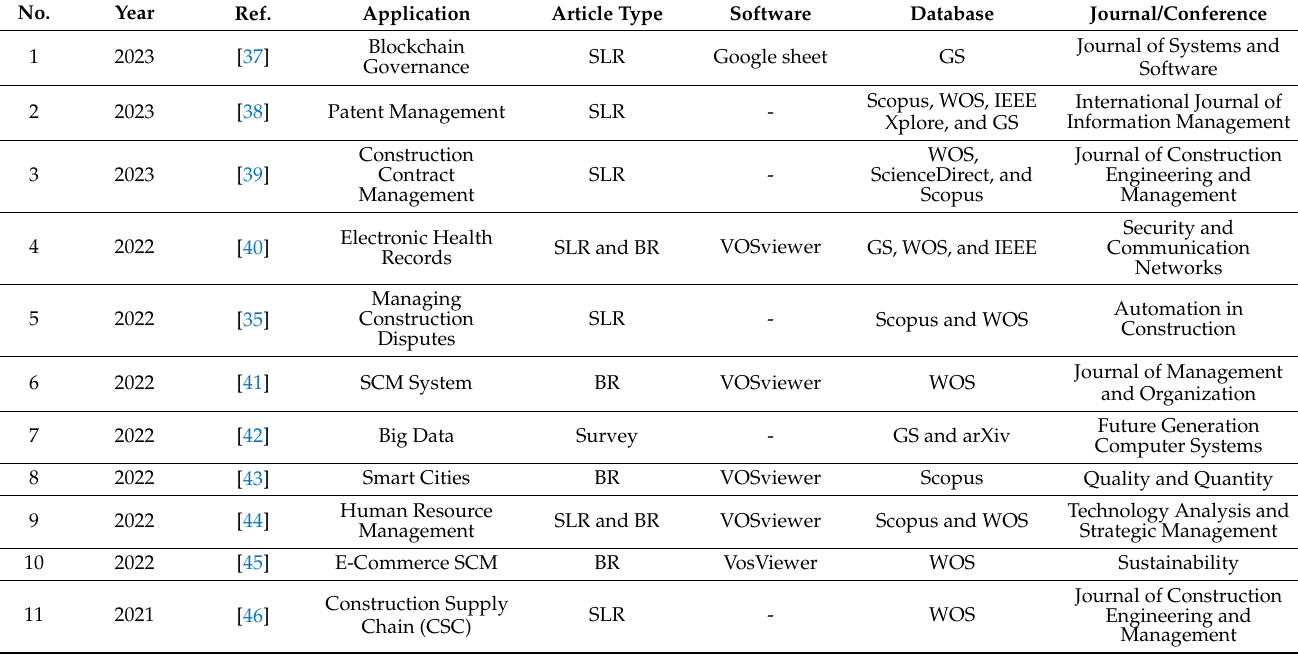
Table 1. Comparing recent review papers on